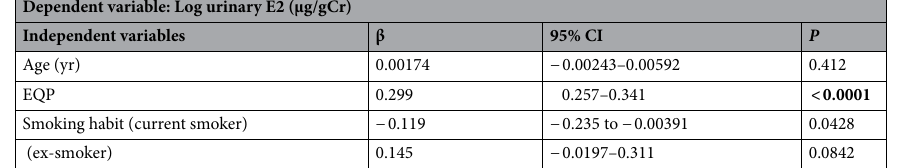
Table 3. Analysis of covariance of urinary estradiol and equol producing status. CI: confidence interval. Analysis of covariance was conducted for log urinary E2 as dependent variable with independent variables (EQP, age and smoking). Age and smoking were included as covariables in addition to EQP in all analyses. EQP status was coded as 1 = EQP and 0 = non-EQP; tobacco use was coded as 1 = non-smoker, 2 = current smoker, and 3 = ex-smoker. Model fitness: R 2 = 0.304.